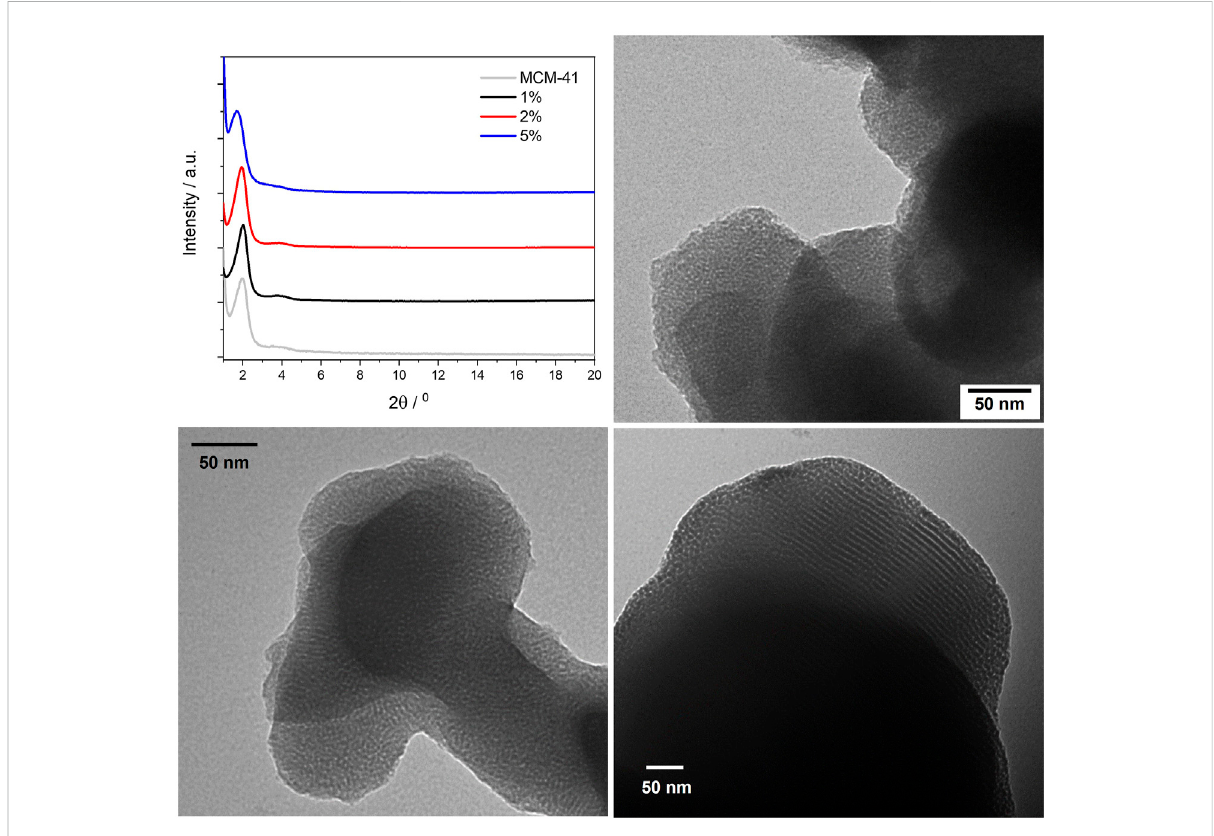
FIGURE 7 PowderX-raydiffractionpatternsoftheBOPHY2-PMOmaterials(topleft);TEMimagesof1%(topright),2%(bottomleft)and5%(bottomright).